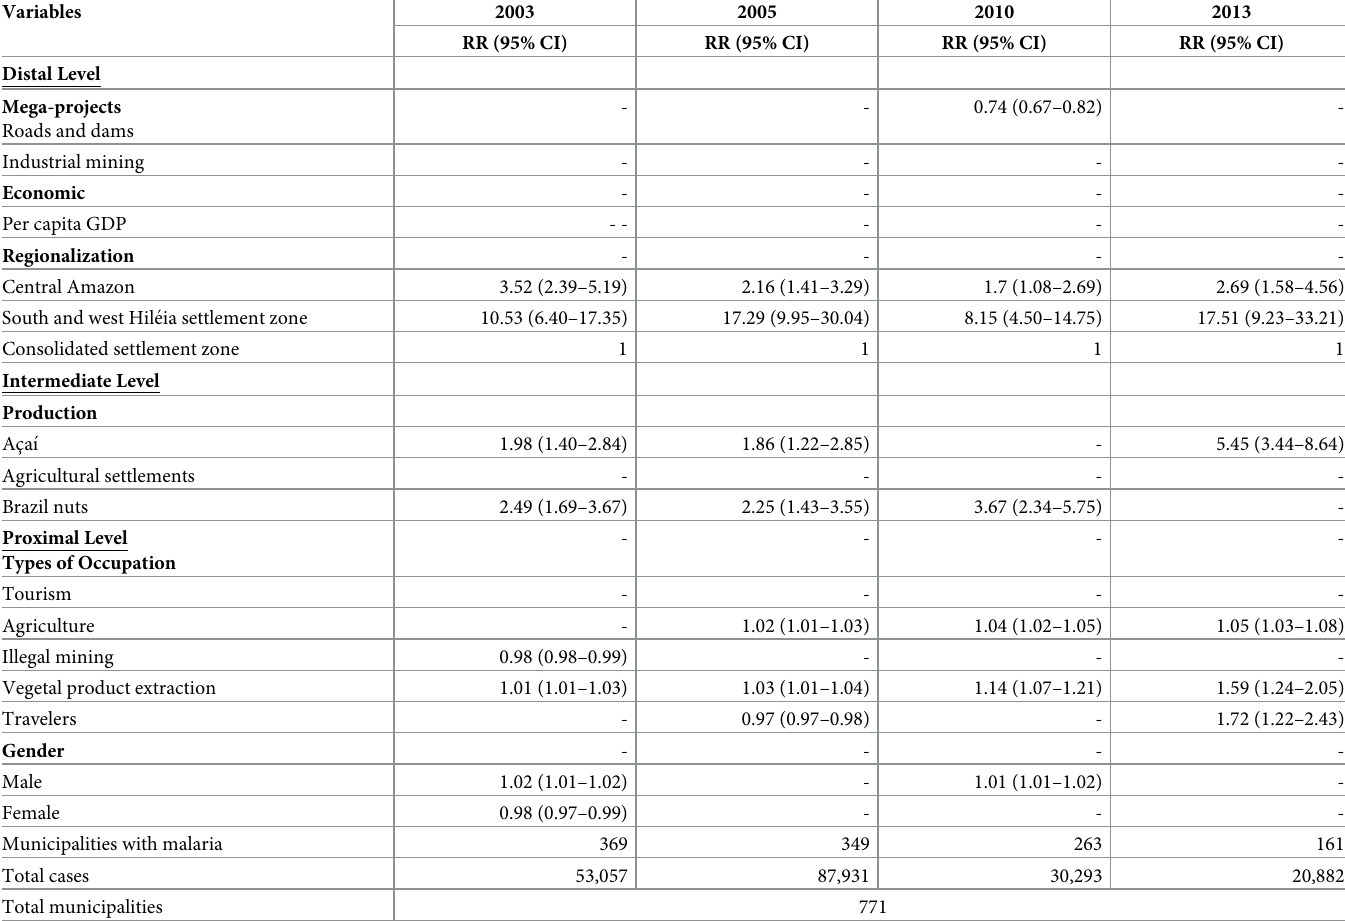
Table 3. Risk factors of malaria associated with occupation for P . falciparum by